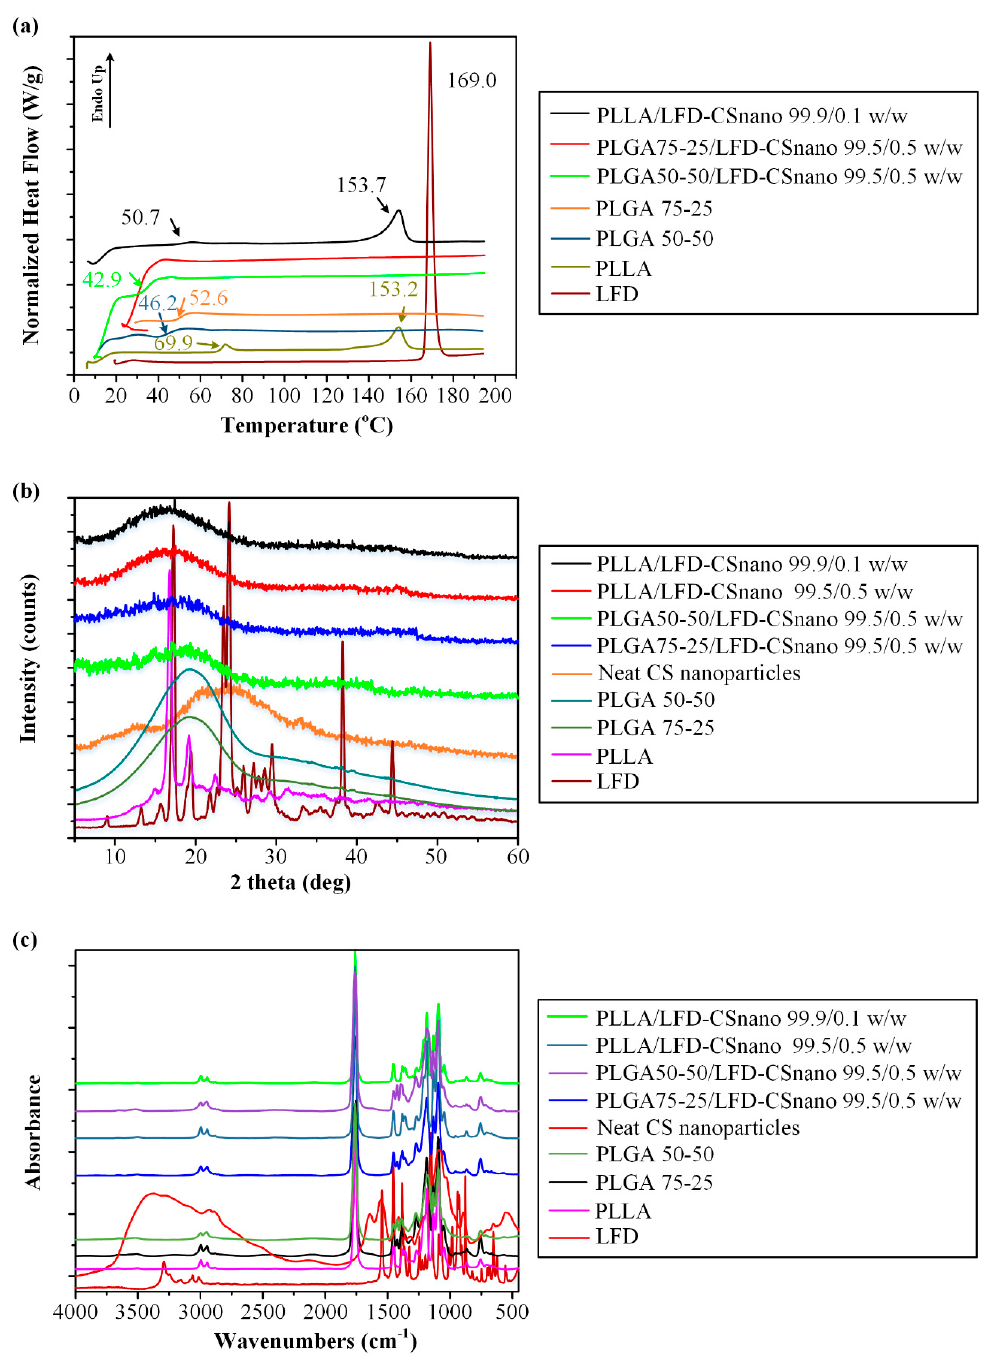
Figure 11. First heating DSC scan thermograms ( a ), pXRD diffractograms ( b ), and FTIR spectra ( c ) analysis of LFD-loaded CS-NPs emended in the PLLA and PLGA thin-films. Results suggest that in all cases, the drug was amorphously dispersed within the pol- yester matrices since no endothermic melting peaks attributed to LFD were recorded. The small endothermic peak observed at 153.7 °C in the case of PLLA-CS NPs can be attributed to the small portion of crystals remaining from PLLA. However, keeping in mind that LFD crystals present within the polyester-CS NP systems may not be detected from the DSC thermograms due to in situ amorphization (i.e., the drug crystals may melt within the DSC pan during the DSC heating process), the physical state of the drug within the prepared systems was also evaluated via pXRD.